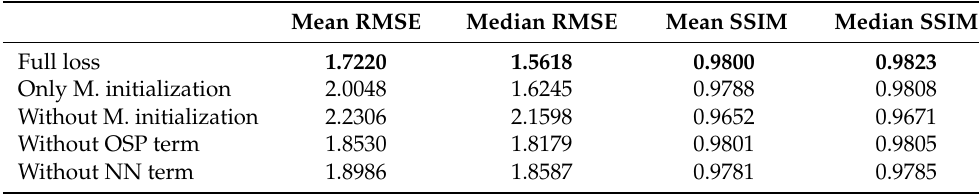
Figure 6. Ablation studies of the proposed multi-view highlight removal on the Laboratory Captured Dataset. ( a ) Input image. ( b ) Ground truth. ( c ) Ours with full loss. ( d ) Ours only with the initialization by the mirror reflection model. ( e ) Ours without initialization by the mirror reflection model. ( c – e ) are setted with λ NN = 10 and λ OSP = 1. ( f ) Ours with λ OSP = 0.1. ( g ) Ours with λ NN = 1. The specular component is rescaled by two for better visualization. Table 3. Ablation Studies of multi-view highlight removal on the Laboratory Captured